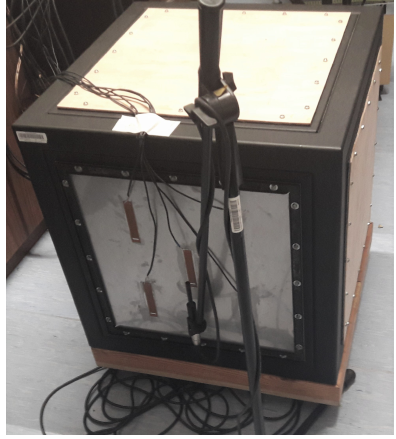
Figure 1. The experimental setup